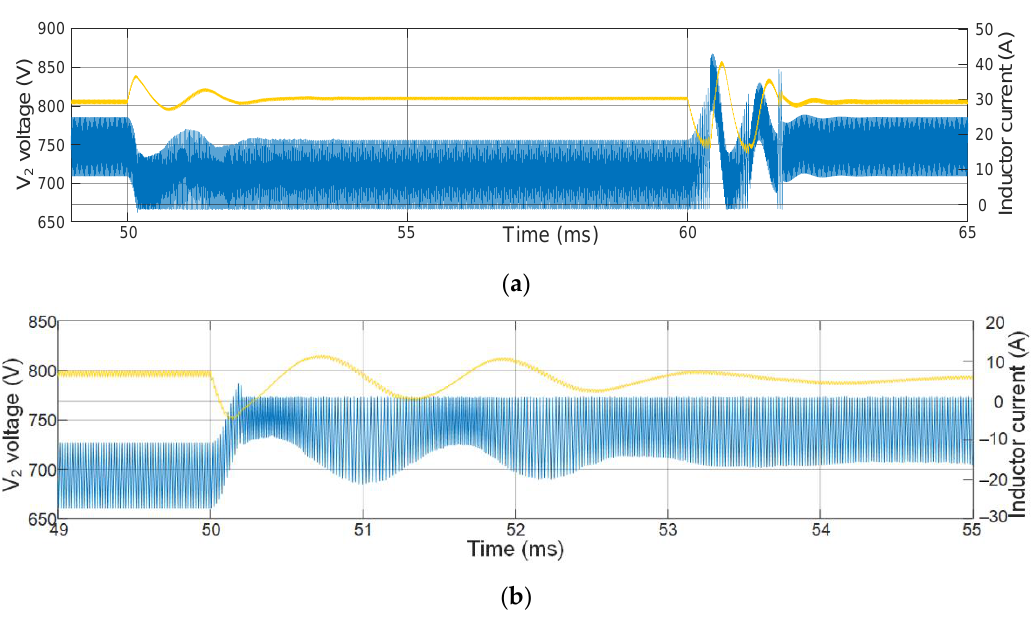
Figure 8. Main waveforms of the event-based DPWM with variable switching frequency implemented for QWS-ZVS operation: I L (green), current event detection signal (blue), DPWM ramp (brown) and gate signals (S 1 in violet, S 2 in red).